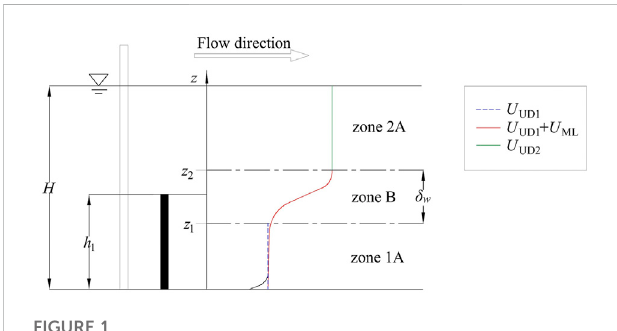
FIGURE 1 Conceptual model for fl ows with double-layered rigid